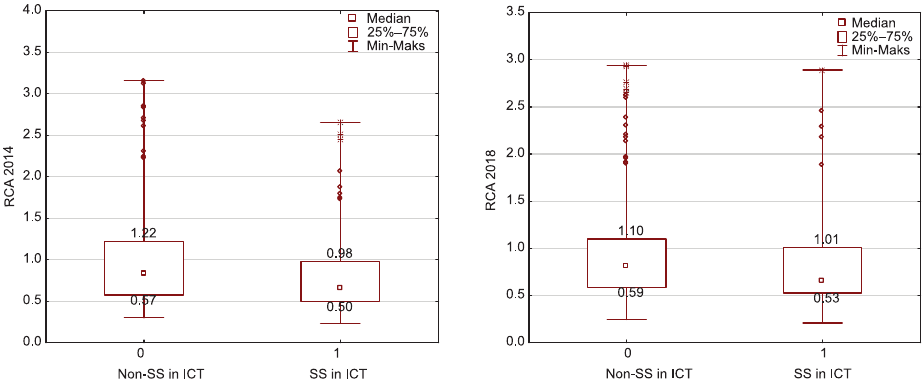
Figure 1. Dispersion measurements for RCA by non-SS in ICT and SS in ICT groups – NUTS2 regions (2014, 2018) (source: